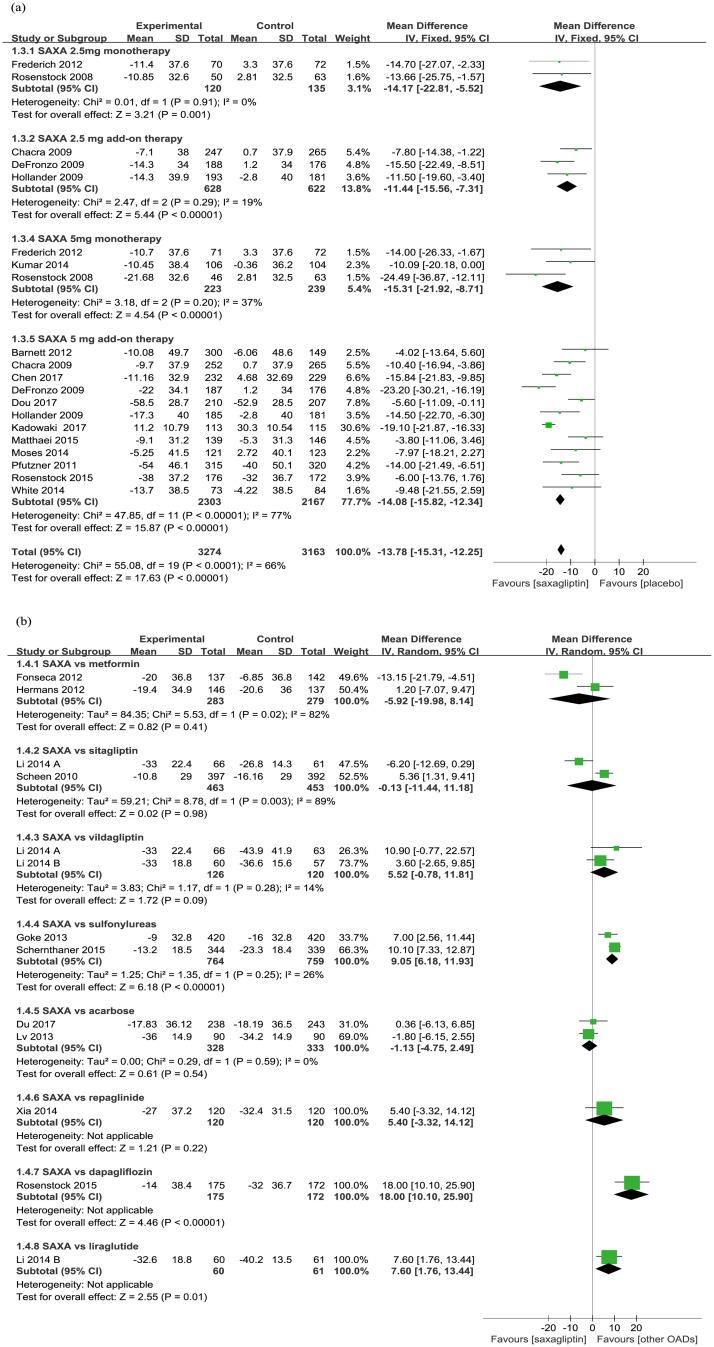
Mean change of FPG from baseline (a. saxagliptin vs placebo; b. saxagliptin vs active comparators).